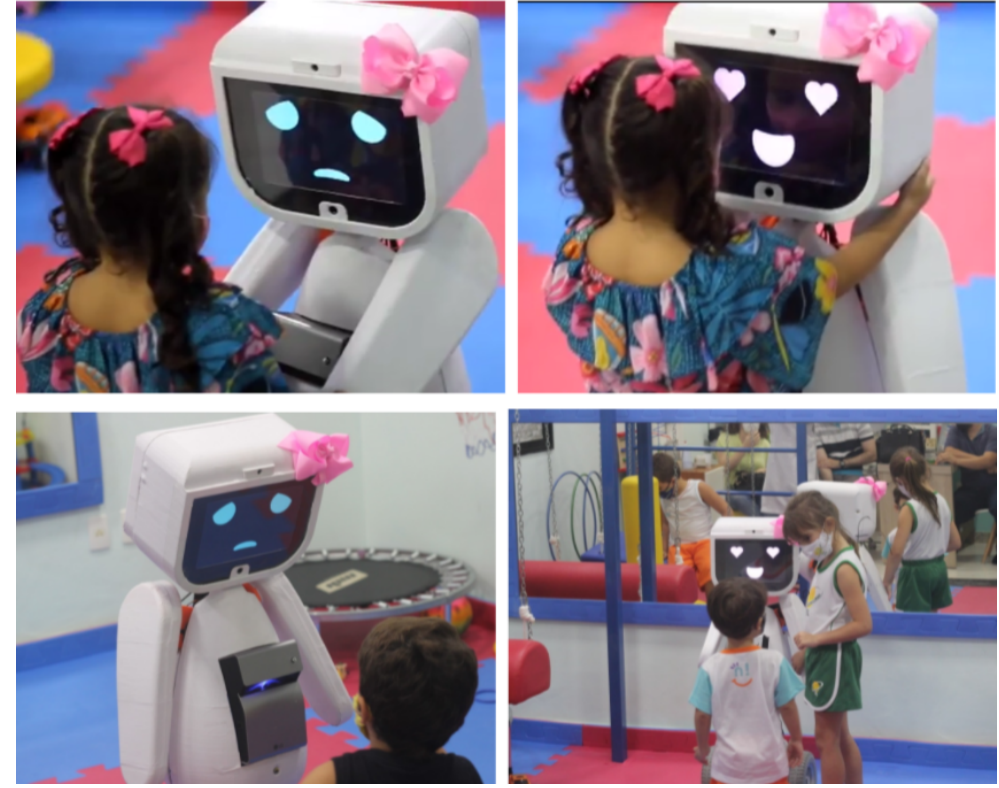
Figure 1. MARIA T21 interacting with children with ASD and DS, and demonstrating its ability to express emotions in the